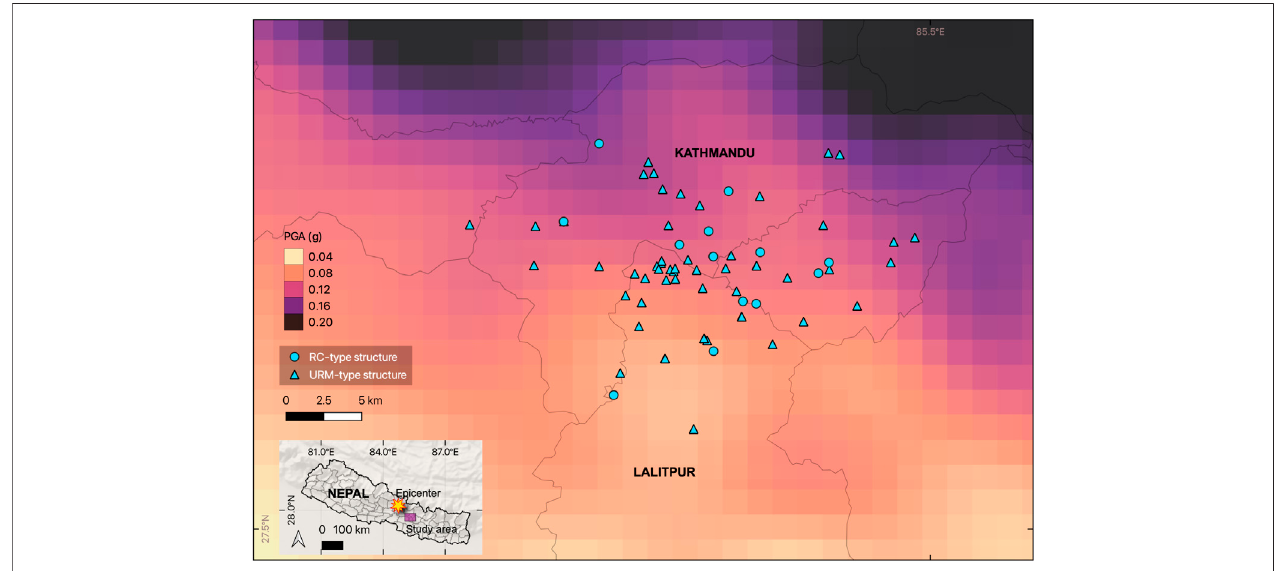
FIGURE 4 | A map of the 70 retro fi tted schools and their corresponding structure type used in the analysis described in Section 5.1 . The basemap shows the hazard model developed by Chen and Wei (2019) for the 2015 Gorkha earthquake in terms of peak ground acceleration (in g-units).